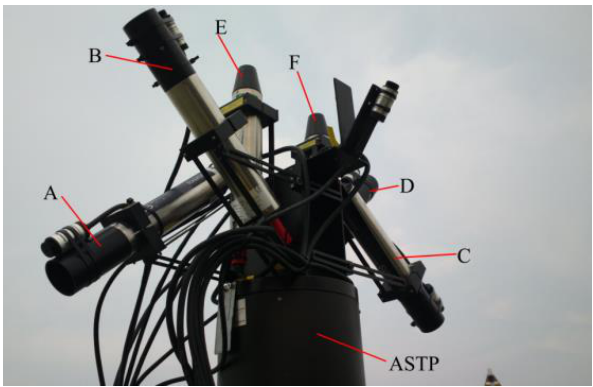
Figure 5. Six hyperspectral TriOS-RAMSES radiometers mounted on the automatic sun-tracking platform (ASTP) of the AFWCPOS, including four RAMSES-ARC sensors for radiance measurement (A, B, C, and D) and two RAMSES-ACC sensors for irradiance observation (E and F).